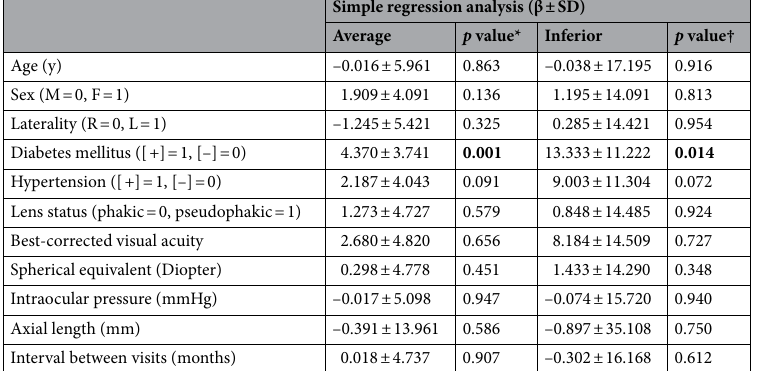
Table 6. Simple regression analysis of the relationships between clinical factors and differences in average and inferior pRNFL thickness measurements at the first and second visits in group W. * p value for the simple regression analysis between differences in average pRNFL thickness measurements and clinical factors. † p